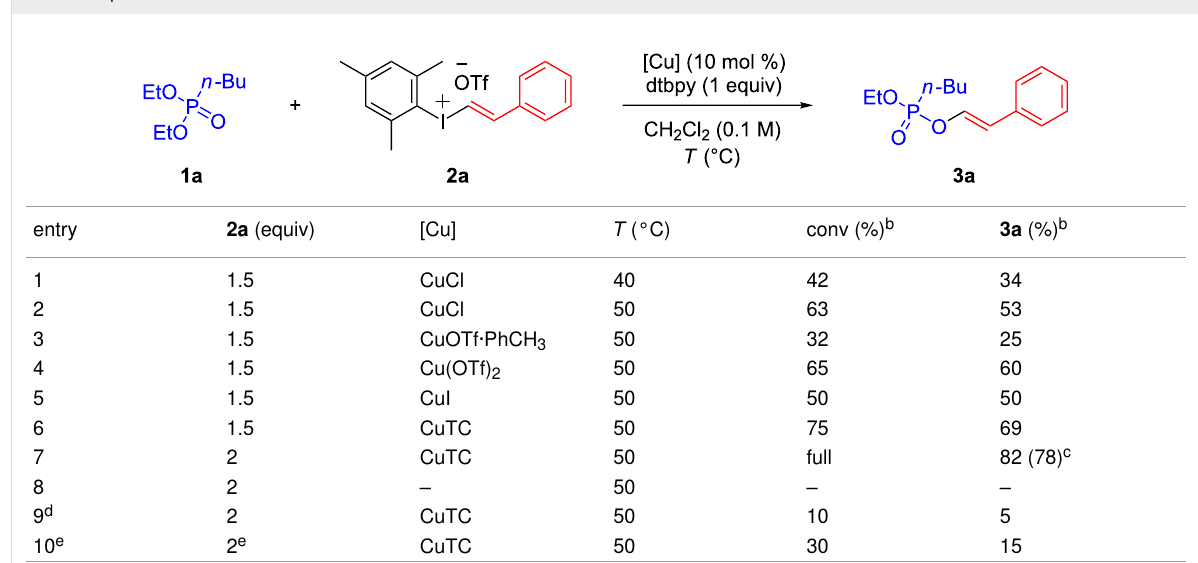
Table 1: Optimization studies a